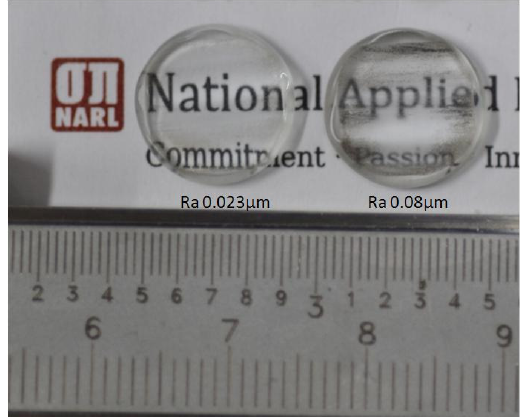
Figure 16. The appearances of glass MLA after PGM; the glass lens on the right was made using a pressing die with a surface roughness of 0.08 µm Ra, while the glass lens on the left was made using a pressing die with a surface roughness of 0.023 µm Ra.